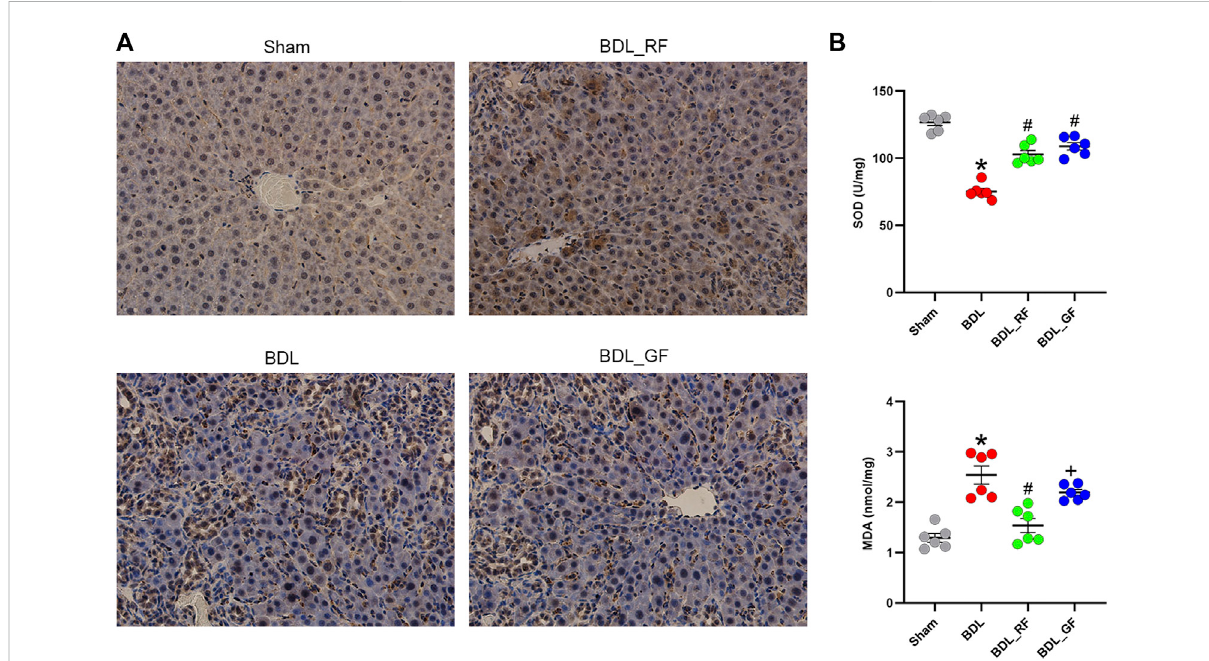
FIGURE 3 Effects of RF and GF on liver oxidative stress of BDL-rats. (A) Representative immunohistochemical staining for NF-E2-related factor 2 (Nrf2) (×400 magni fi cation) of liver tissues. (B) Superoxide dismutase (SOD) and malondialdehyde (MDA) levels of liver tissues. (*: p < 0.05, compared with the Sham group; #: p < 0.05, compared with the BDL group; +: p < 0.05, compared with the BDL_RF group, n =